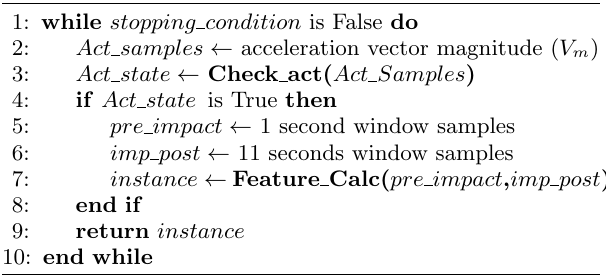
Algorithm 1 Cascade-classifier